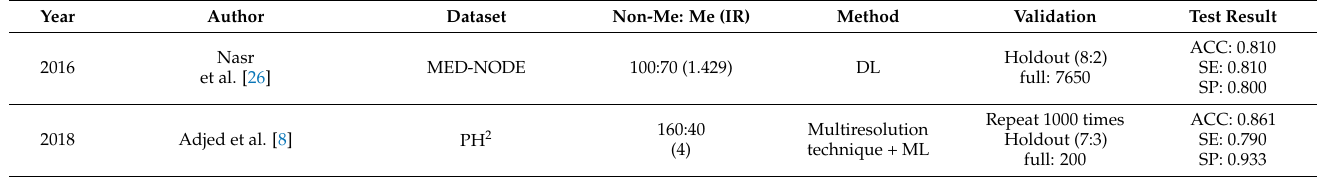
Table 14. A comparative summary of the existing techniques for melanoma binary